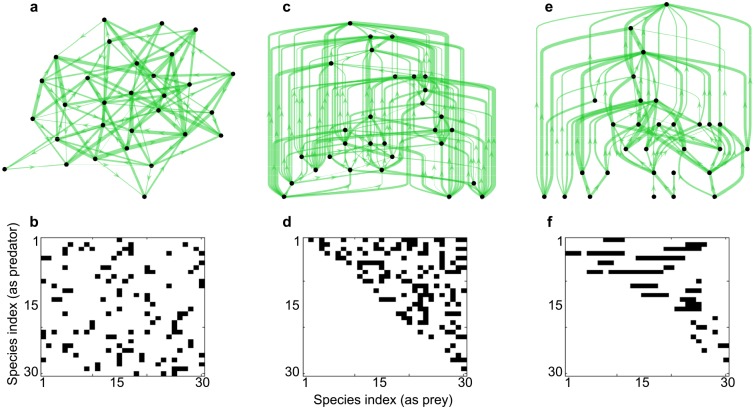
Illustration of some predator-prey networks and adjacency matrices.(a-b) Unstructured model for predation. (c-d) The cascade model. (e-f) The niche model. The parameters are C = 0.25 and S = 30. Thicker green arrows represent larger interaction strengths. Only positive interactions are represented.